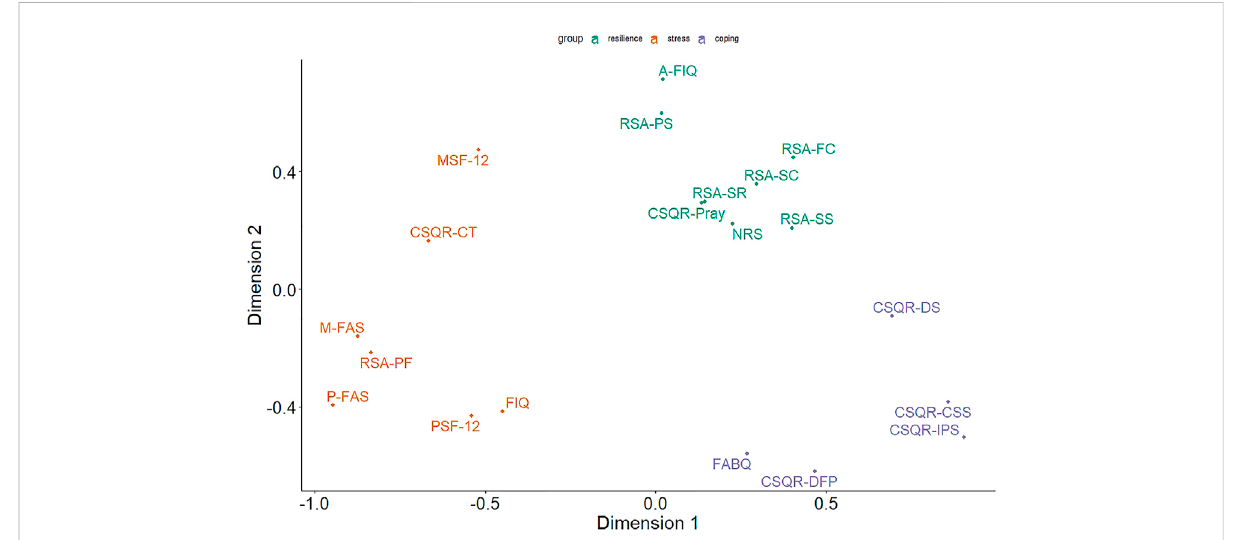
FIGURE 3 Multidimensional scaling diagram of scales of physical distress and fear, physical and mental disability, resilience and coping ability. NRS = numeric rating scale; P-FAS = physical fatigue assessment scale; M-FAS = mental fatigue assessment scale; FABQ = fear avoidance belief questionnaire; FIQ = fi bromyalgia impact questionnaire; A-FIQ = anxiety fi bromyalgia impact questionnaire; PSF-12 = physical 12-item short form survey; MSF-12 = mental 12-item short form survey; RSA = resilience scale for adults (subscales: PS = perception of self; PF = planned future; SC = social competence; SS = structured style; FC = family cohesion; SR = social resources); CSQR = coping strategies questionnaire-revised (subscale: DS = distraction; CT = catastrophizing; IPS = ignoring pain sensations; DFP = distancing from pain; CSS = coping self-statements; Pray =